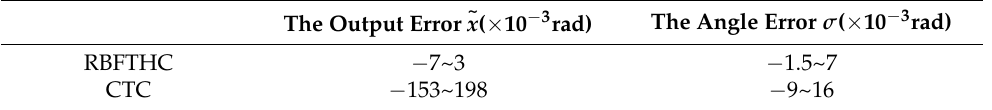
Table 5. The simulation 3